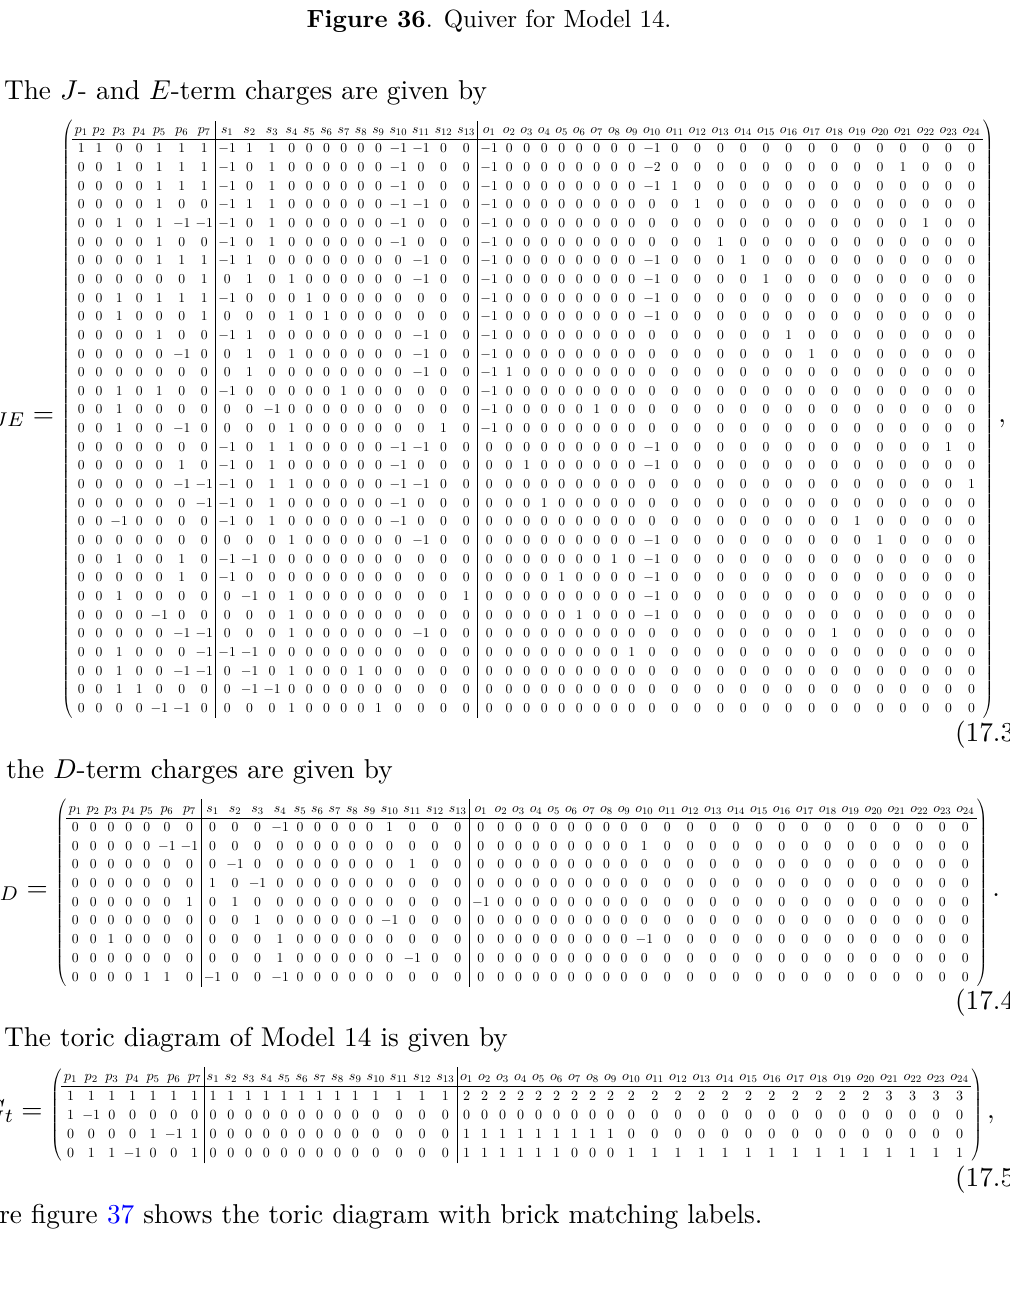
Figure 36 . Quiver for Model